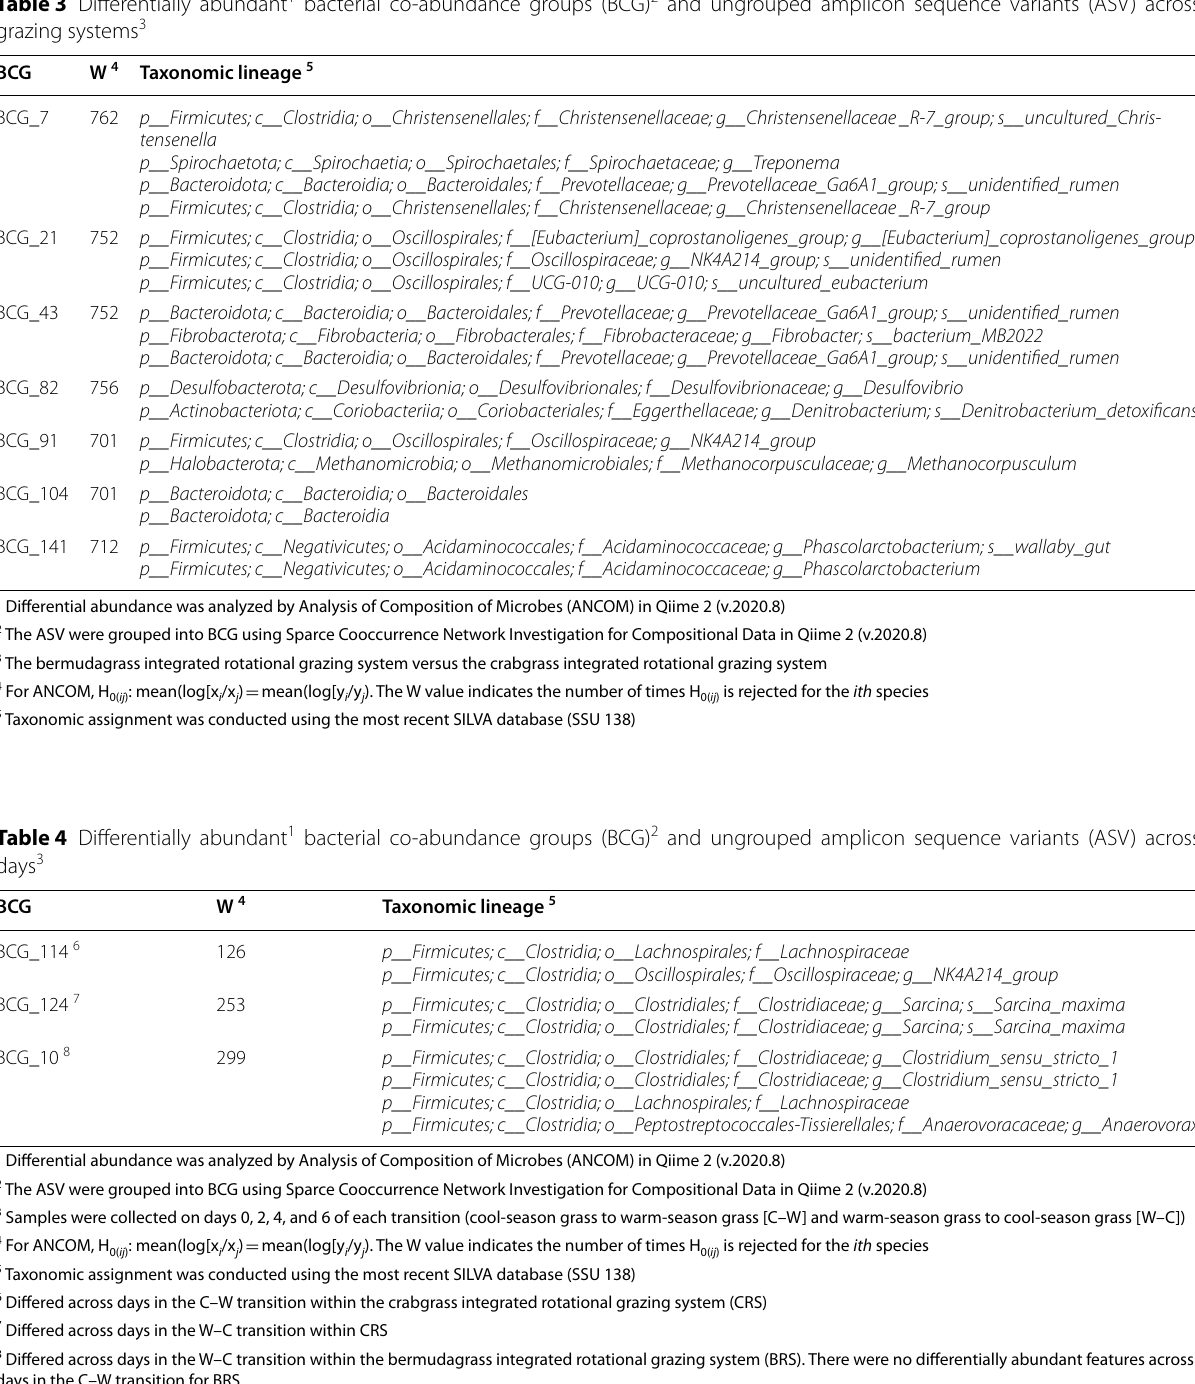
Table 3 Differentially abundant 1 bacterial co‑abundance groups (BCG) 2 and ungrouped amplicon sequence variants (ASV) across grazing systems 3